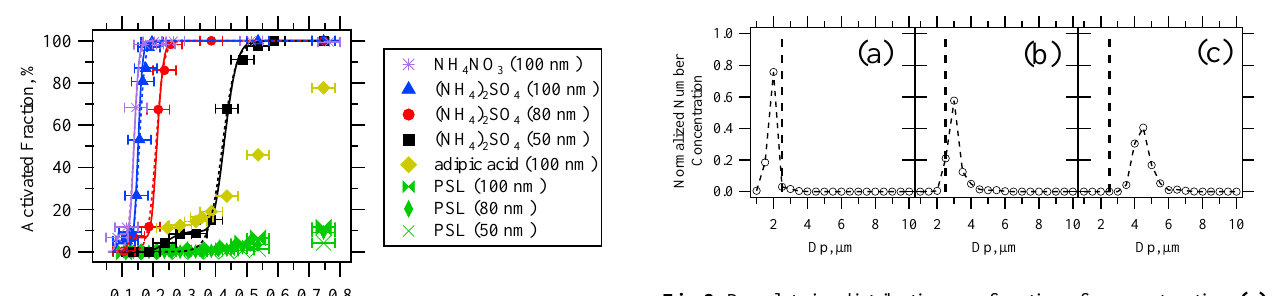
Fig. 3. Droplet size distribution as a function of supersaturation, (a) 0.25%, (b) 0.5%, and (c) 0.75%, for ammonium sulfate. Note that vertical extension of dashed line in each panel represents the D 50 cut-size of ∼ 2.5µm diameter for the PCVI.